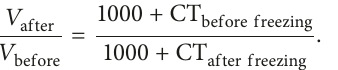
Figure 1: Experimental design for evaluation of CREKA imaging agents for a metastatic breast cancer model. GFP-labeled, 4T1 cells were injected in the fat pad. CREKA-Cy5 was injected in the tail vein for fluorescence evaluation. After 3 hours to allow clearance of nonbound agent, CREKA-Gd was injected. With MRI, we captured in vivo and high resolution ex vivo image volumes. After embedding in the freezing medium and snap freezing, we acquired microscopic, anatomical, colored episcopic and molecular, multispectralfluorescencecryo-imagevolumes.Optionally,selected histological sections were manually acquired using a tape